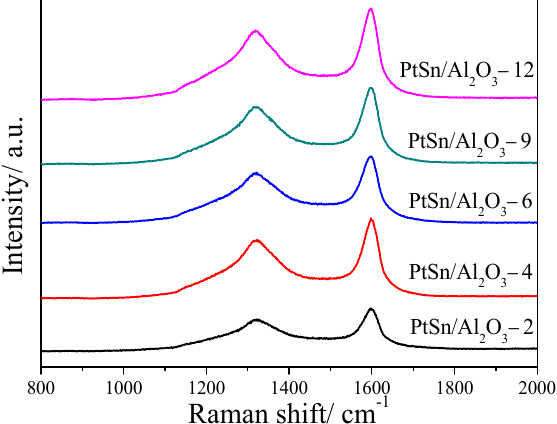
Figure 8. Raman spectra of PtSn/Al 2 O 3 catalysts after 6 h of